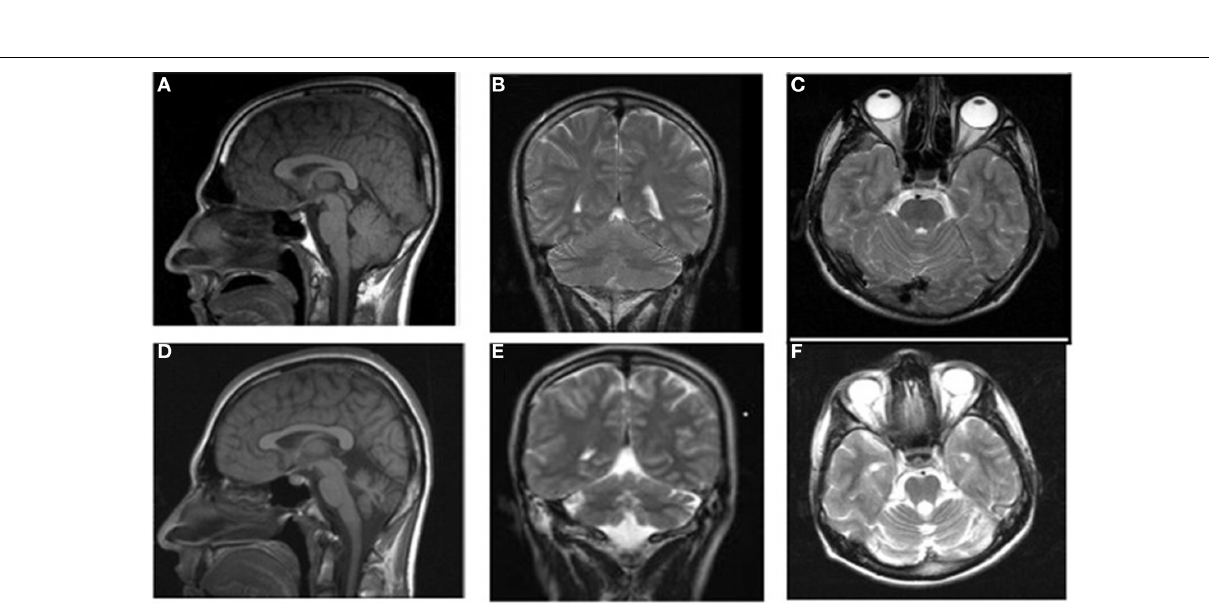
Frontiers in Neuroscience | Evolutionary Psychology and Neuroscience April 2014 | Volume 8 | Article 84 |